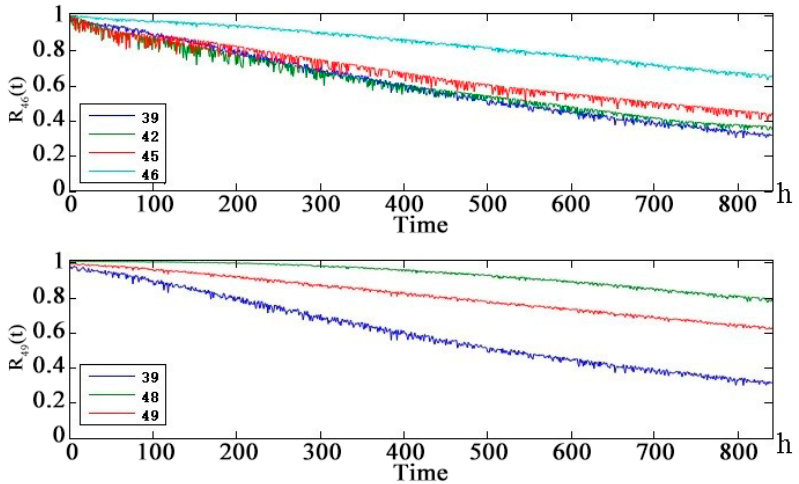
Figure 11. Health state probability prediction curve of Solar-powered UAV data-link intermediate node future 840 h.